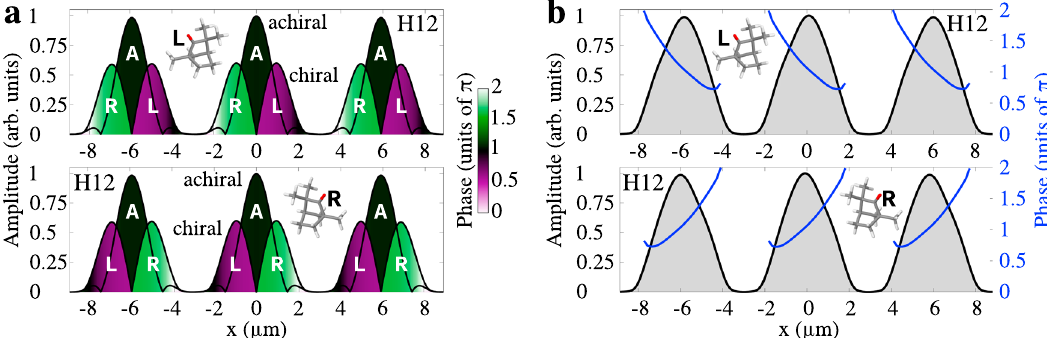
Fig. 3 Enantio-sensitive nonlinear response of chiral matter to chirality-polarized light. a Amplitude of the achiral and chiral components of the nonlinear response driven by the space-time light structure presented in Fig. 2 in randomly oriented left-handed (upper panel) and right-handed (lower panel) fenchone molecules at frequency 12 ω ; the phase is encoded in the colors. b Amplitude (black) and phase (blue) of the total nonlinear response in the near fi eld resulting from adding the achiral and chiral components of ( a ) for left-handed (upper panel) and right-handed (lower panel) fenchone. Laser parameters are the same as in Fig. 2 with ϕ ð 1 Þ ω ; ¼ ϕ ð 2 Þ ω ; ¼ 0 : 44 π 2 ω 2 ω